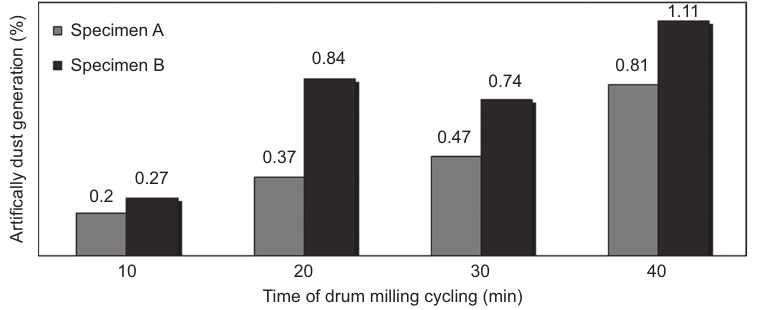
Figure 2 Preliminary trials of drum rotation for dust generation on the aggregate